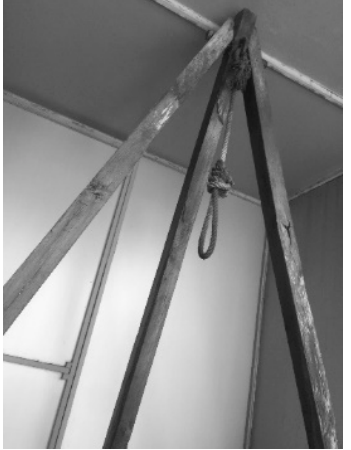
Figure 18. A view of the gallows at Ulucanlar